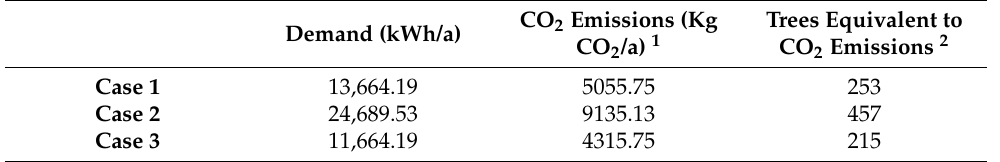
Table 10. Conversion of annual savings from kilowatt-hours (kWh) to kilograms (kg) of CO 2 in the Madrid case